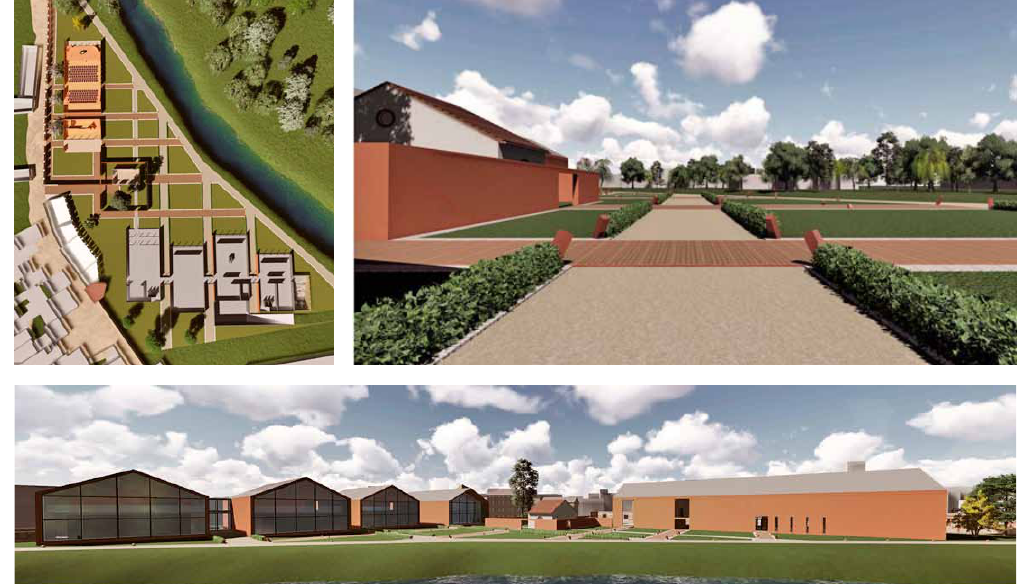
fig. 6. The urban park proposed by the students alessandra Bardini and Marco Campagnola. Planivolumetric plan and views of the site (Bardini, Campagnola